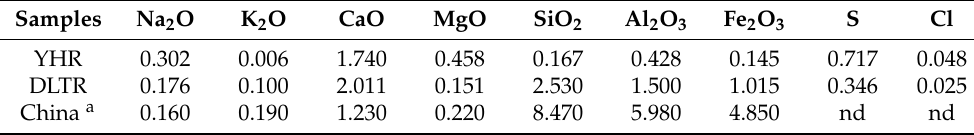
Table 2. Main composition (wt%) of raw coals (on a whole-coal air-dried basis).